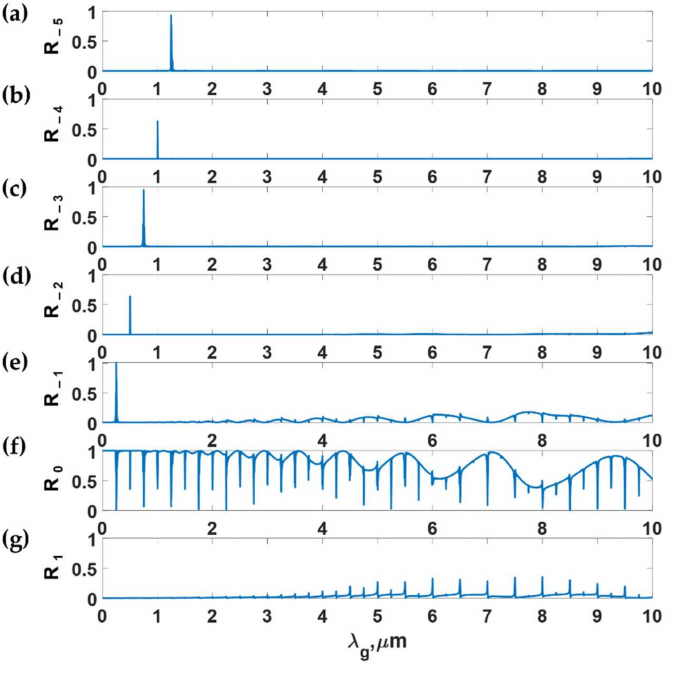
Figure 12. The diffraction efficiencies of ( a ) the − 5th order, ( b ) the − 4th order, ( c ) the − 3rd order, ( d ) the − 2nd order, ( e ) the − 1st order, ( f ) the 0th order, and ( g ) the 1st order; the efficiencies calculated using RCWA for the gratings varying λ g from 0 to 10 µ m, F.F. of 0.5, d of 11 µ m, and d g of 9.75 µ m when illuminated by TM polarized light at 685 nm and the n 0 sin θ 0 of